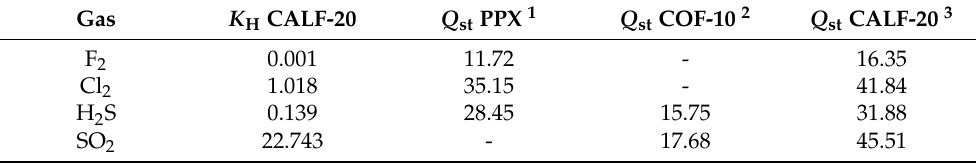
Table 1. The values for Henry coefficient ( K H ) and isosteric heat of adsorption ( Q st ). Gas K H CALF-20 Q st PPX 1 Q st COF-10 2 Q st CALF-20 3 F 2 0.001 11.72 - 16.35 Cl 2 1.018 35.15 - 41.84 H 2 S 0.139 28.45 15.75 31.88 SO 2 22.743 - 17.68